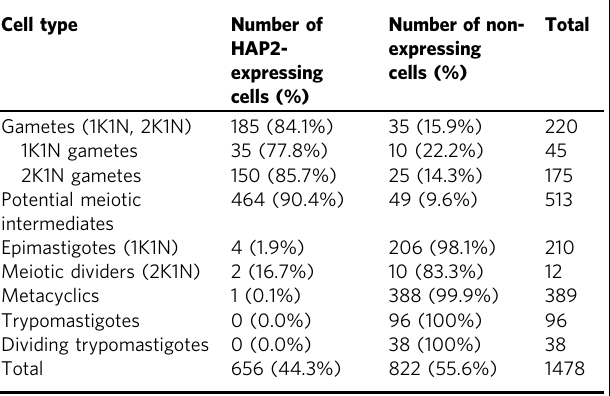
Table 2 Expression of HAP2::YFP in salivary gland-derived trypanosomes of TREU